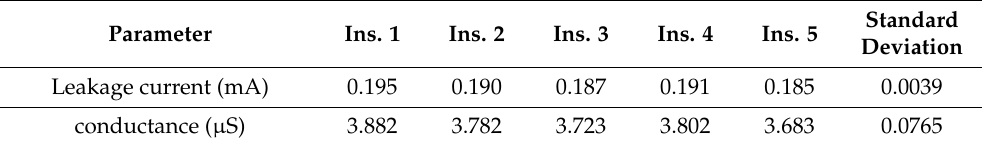
Table 1. Reference leakage current and surface